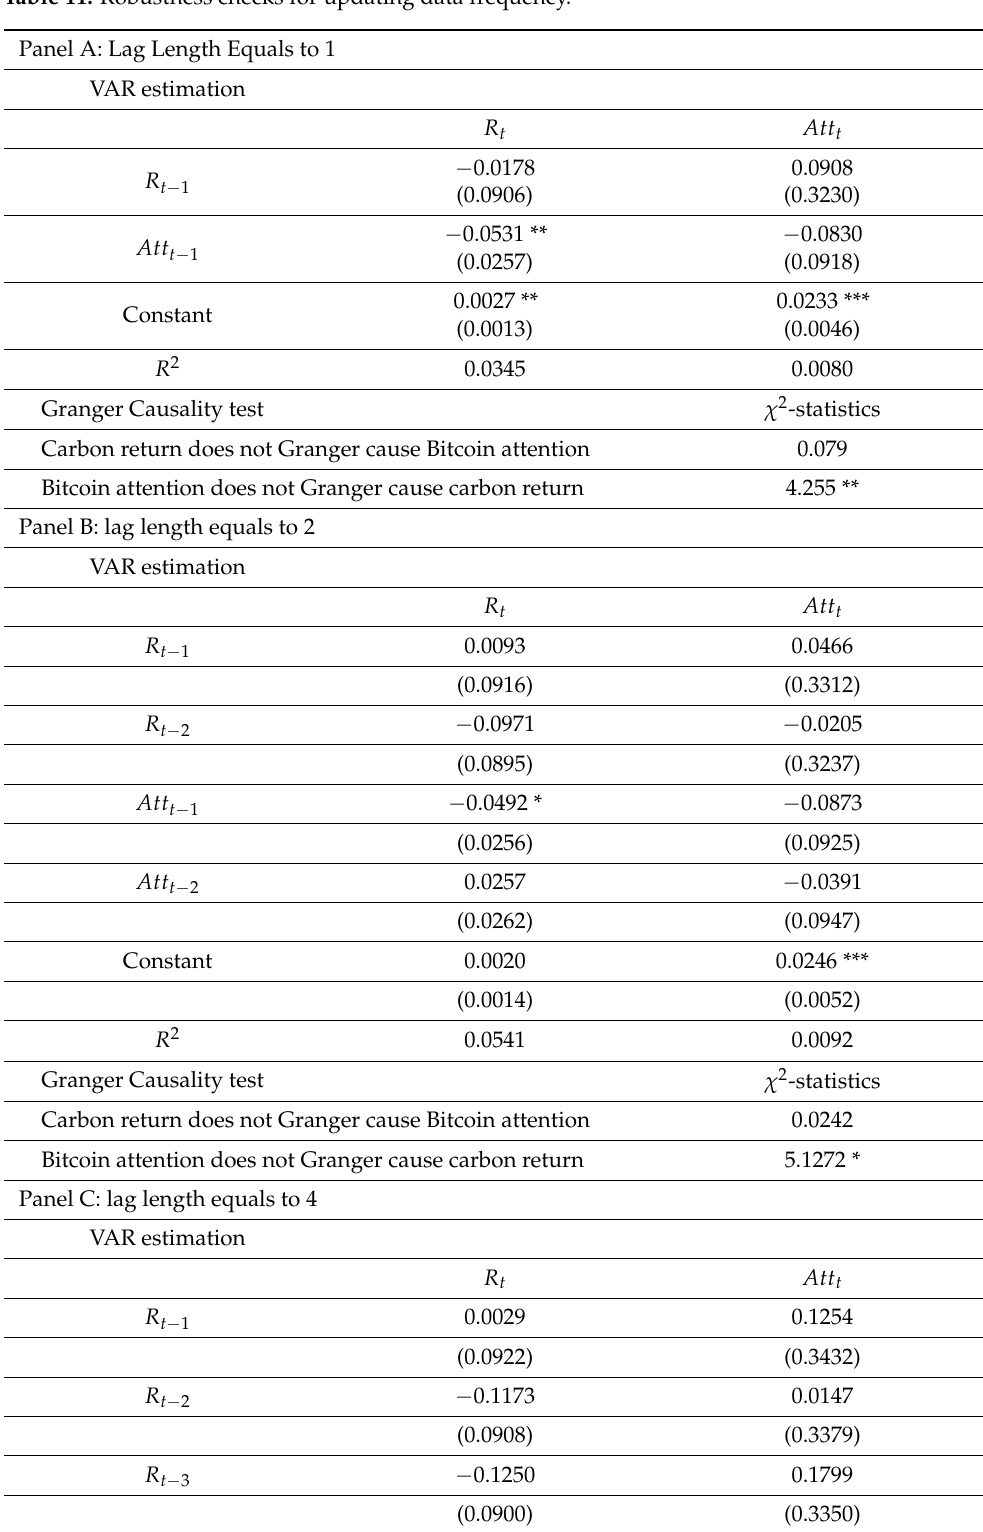
Table 11. Robustness checks for updating data